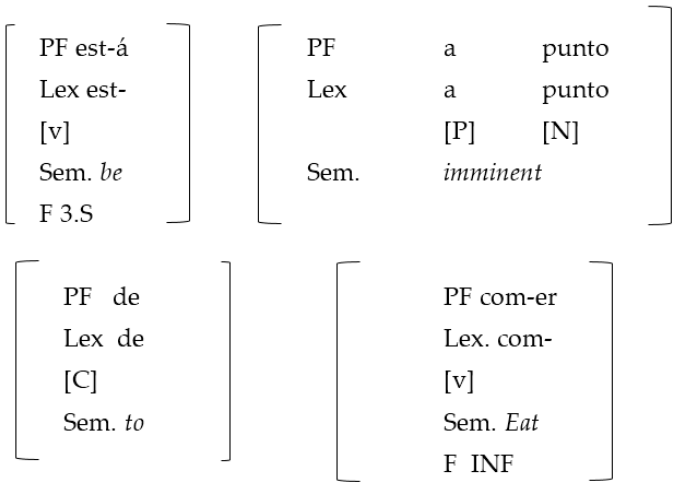
Figure 4. Alignment for est á a punto de comer in